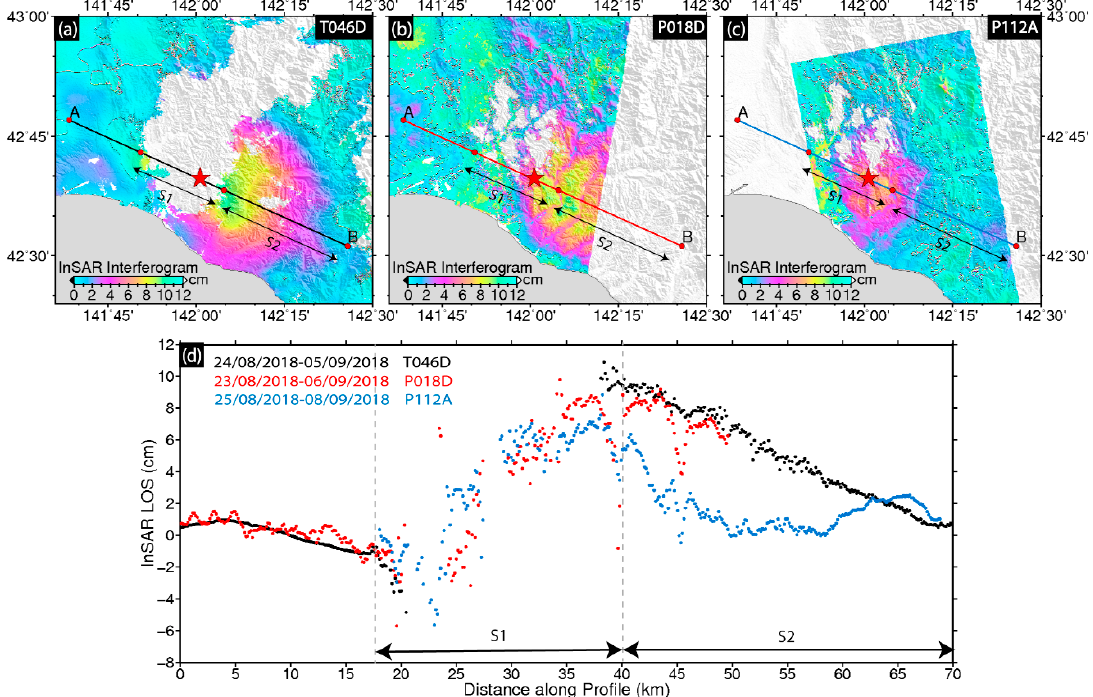
Figure 3. Coseismic interferograms obtained from descending Sentinel-1A track T046D ( a ), descending ALOS-2 track P018D ( b ), and ascending ALOS-2 track P112A ( c ). The interferograms are rewrapped with an interval of 12 cm. Coseismic displacements ( d ) observed on these three tracks along profile AB.